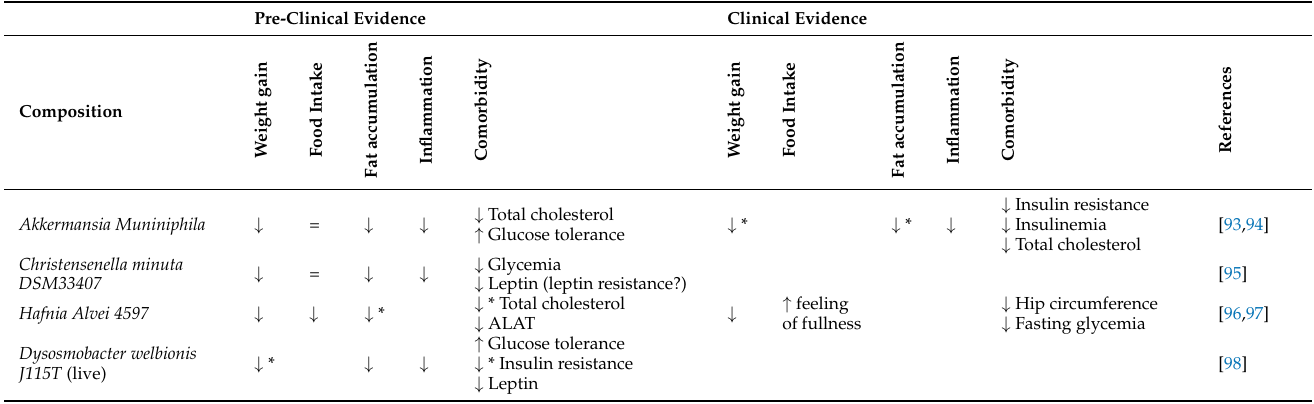
Table 1. Next-generation probiotics’ efficacy in the care of obesity in animal and human clinical